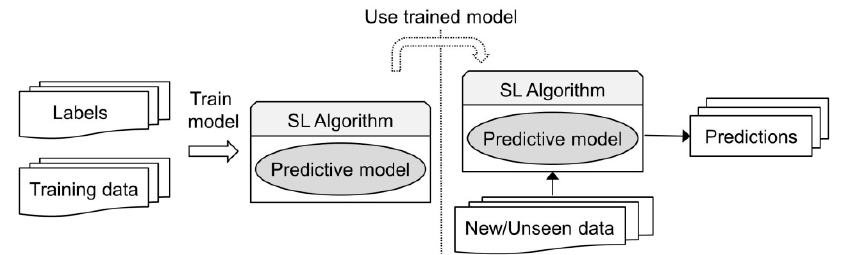
Figure 1. The supervised learning cycle. A labeled dataset (i.e., the training data with the corresponding labels) is used to train a Supervised Learning (SL) algorithm. The resultant predictive model is used to make predictions on new yet unseen data.